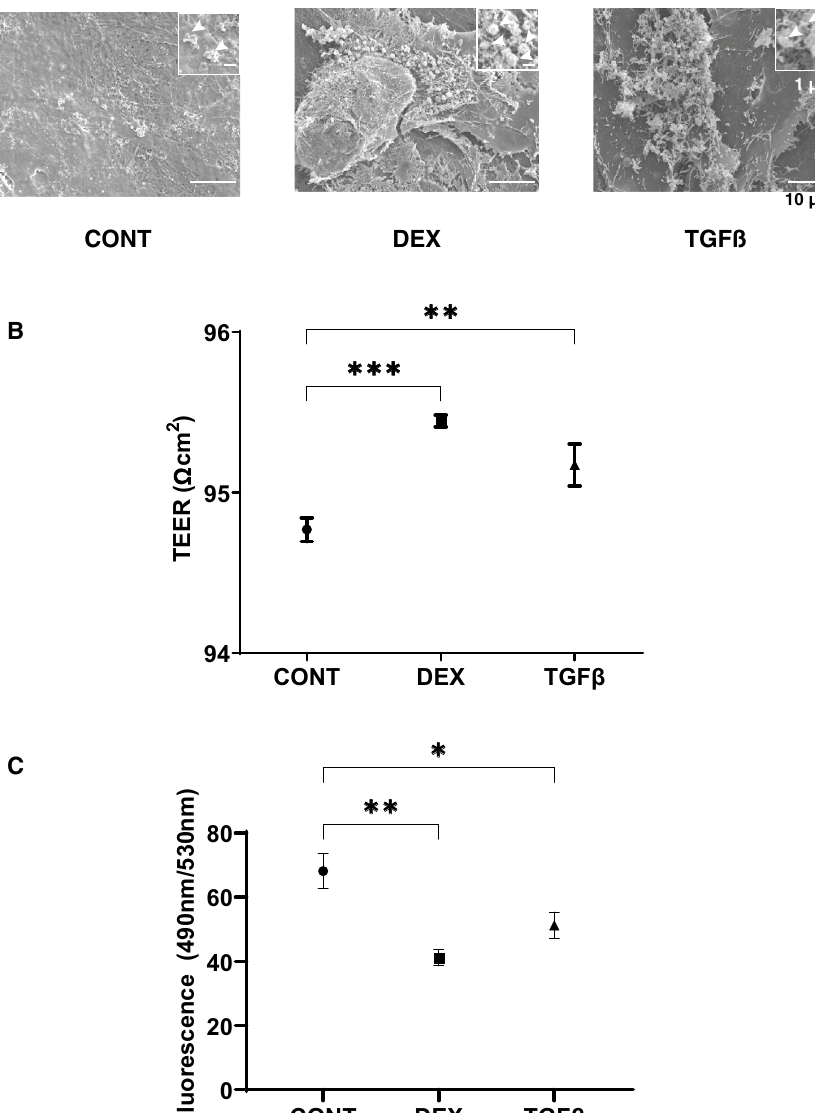
Figure 1. Representative scanning electron microscopic (SEM) images ( A ), transendothelial electrical resistance (TEER) ( B ) and FITC-dextran permeability ( C ) of 2D culture of HTM cell monolayer. Among the experimental groups treated without (CONT) or with 250 nM DEX or 5 ng/ml TGFβ2 (TGFβ), representative SEM images of 2D cultures HTM monolayer at Day 6 are shown (panel A , scale bar; 10 µm). Extracellular ECM deposits indicated by asterisks within inset of SEM images (scale bar; 1 µm) and numbers of ECM deposits within 5 × 5 µm 2 (n = 5 different areas from 4 different preparations) were counted (CONT; 2.75 ± 1.47, DEX; 4.25 ± 0.83, TGFβ; 5.75 ± 0.83). To evaluate barrier function (Ω cm 2 ) and the permeability of the 2D cultured HTM monolayers, TEER (panel B ) and FITC-dextran permeability (panel C ) measurements were made, respectively. All experiments were performed in triplicate using fresh preparations (n = 4). All data are presented as the arithmetic mean ± standard error of the mean (SEM). * P < 0.05, ** P < 0.01, *** P < 0.005 (ANOVA followed by a Tukey’s multiple comparison